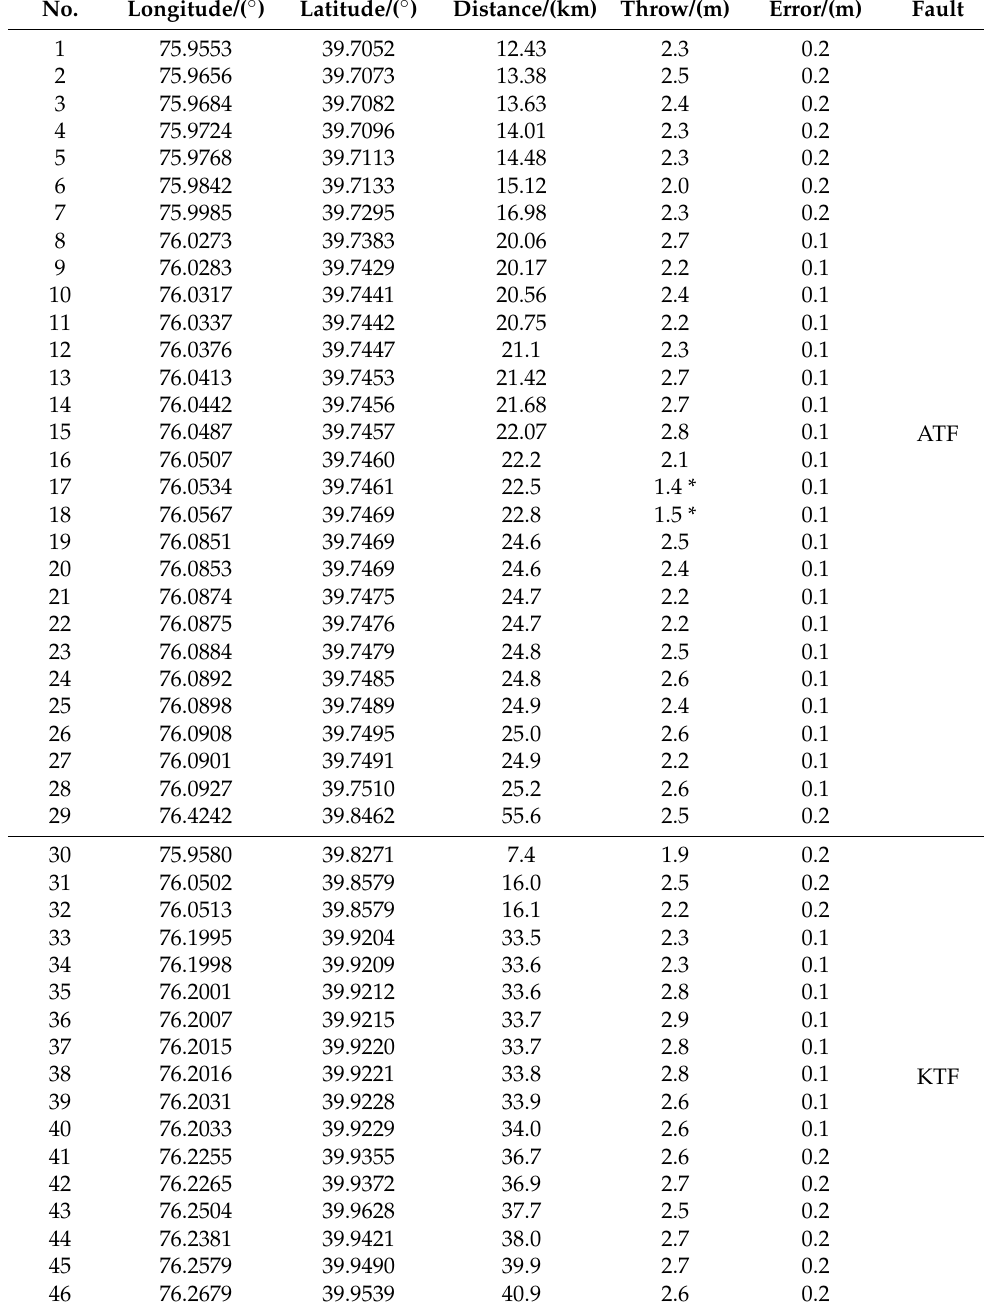
Table 1. Throws measured along the ATF and